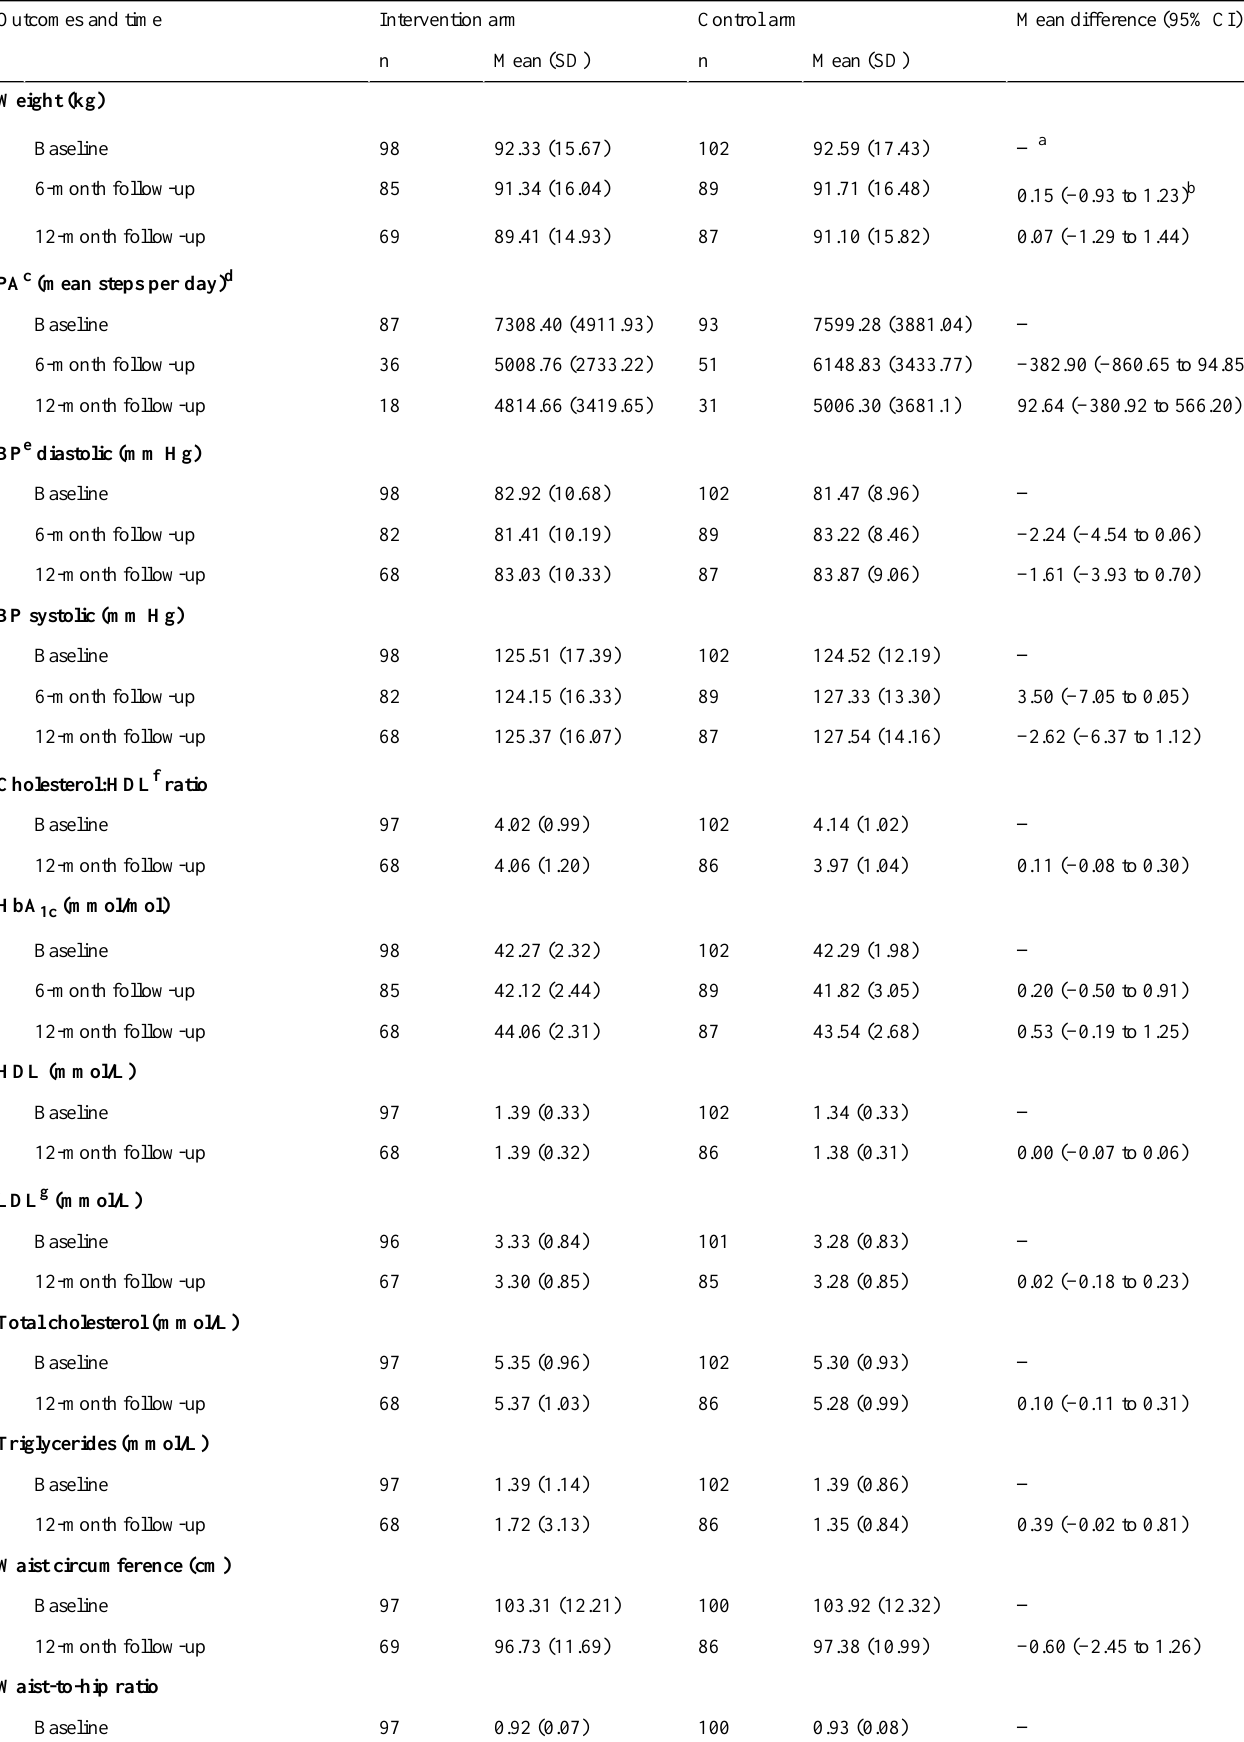
Table 2. Summary of primary and secondary outcomes and pairwise